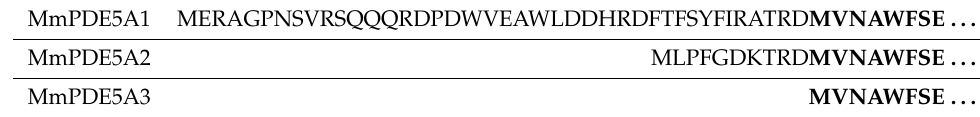
Table 1. Primary structure of MmPDE5 N-terminus. In bold the one-letter amino acid code of the common sequence. Isoforms A1 and A3 are translated from two different start codons on the same mRNA, isoform A2 comes from an alternatively spliced exon. The result is that MmPDE5A1 has 41 amino acids more and MmPDE5A2 10 amino acids more than MmPDE5A3. MmPDE5A1 MERAGPNSVRSQQQRDPDWVEAWLDDHRDFTFSYFIRATRD MVNAWFSE . . . MmPDE5A2 MLPFGDKTRD MVNAWFSE . . . MmPDE5A3 MVNAWFSE . .